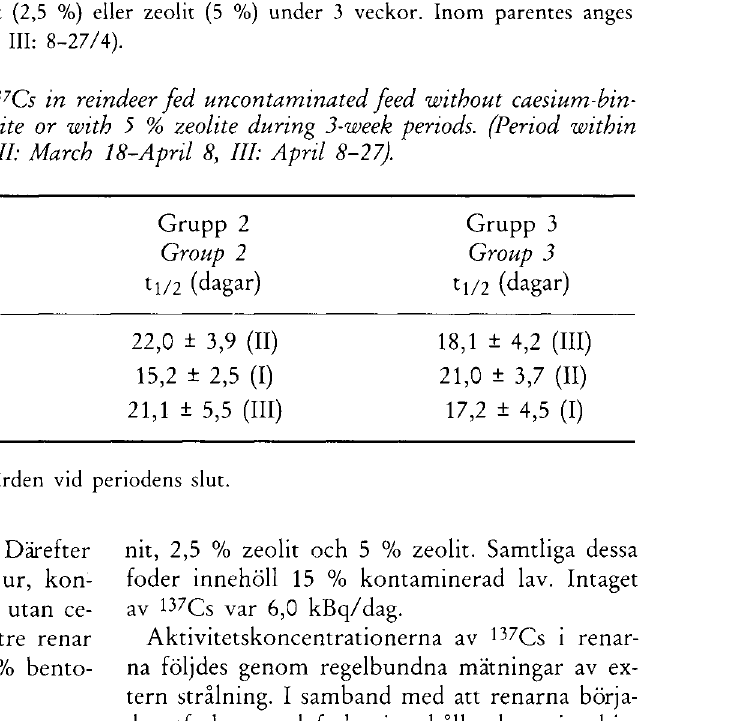
Tabell 1. Halveringstid (dagar, medelvarde ± S.D) for 137 Cs i renar utfodrade med foder utan cesiumbindare (kontroll) respektive med bentonit (2,5 %) eller zeolit (5 %) under 3 veckor. Inom parentes anges period (I: 26/2-18/3, II: 18/3-8/4, III: 8-27/4). Table 1. Half-time (days, mean ± S.D.) for 137 Cs in reindeer fed uncontaminated feed without caesium-bin der (controls), with 2.5 % bentonite or with 5 % zeolite during 3-week periods. (Period within parenthesis; I: Feb 26-March 18, II: March 18-April 8, III: April 8-27).